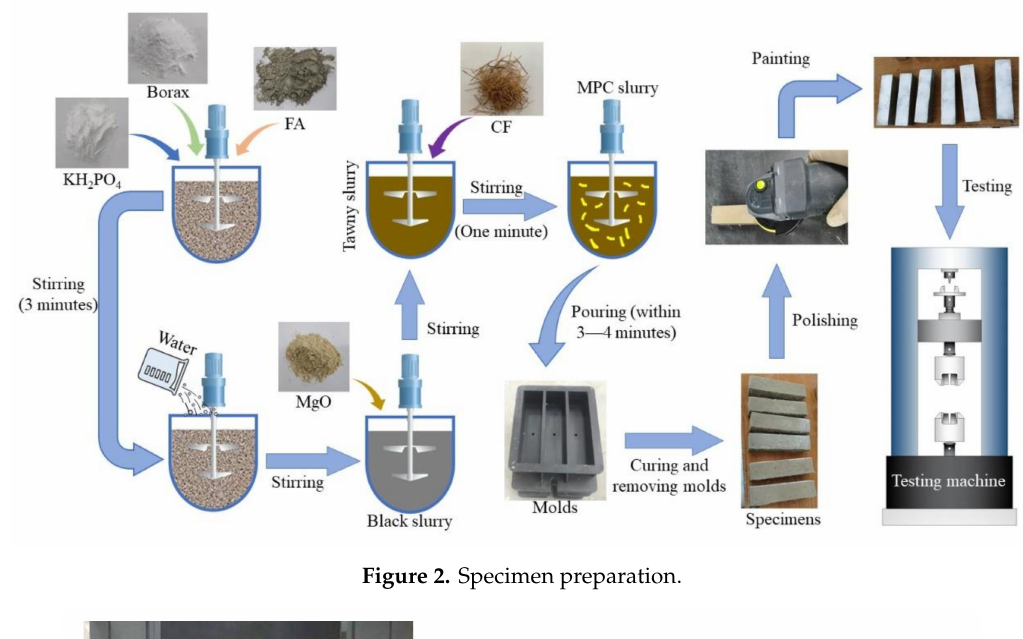
Figure 2. Specimen preparation.